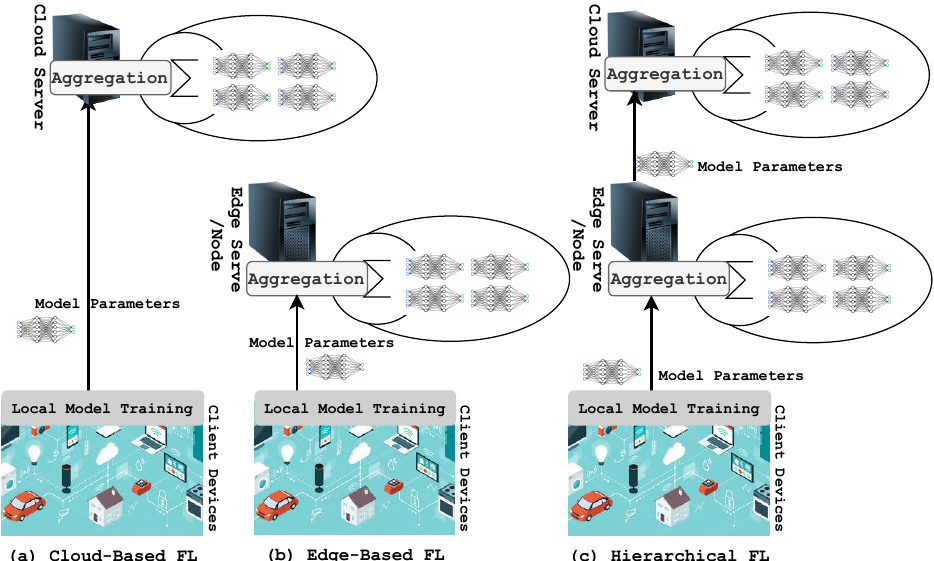
Figure 1. Three federated learning structures: ( a ). Cloud-enabled, ( b ) edge-enabled, and ( c ) hierarchi- cal